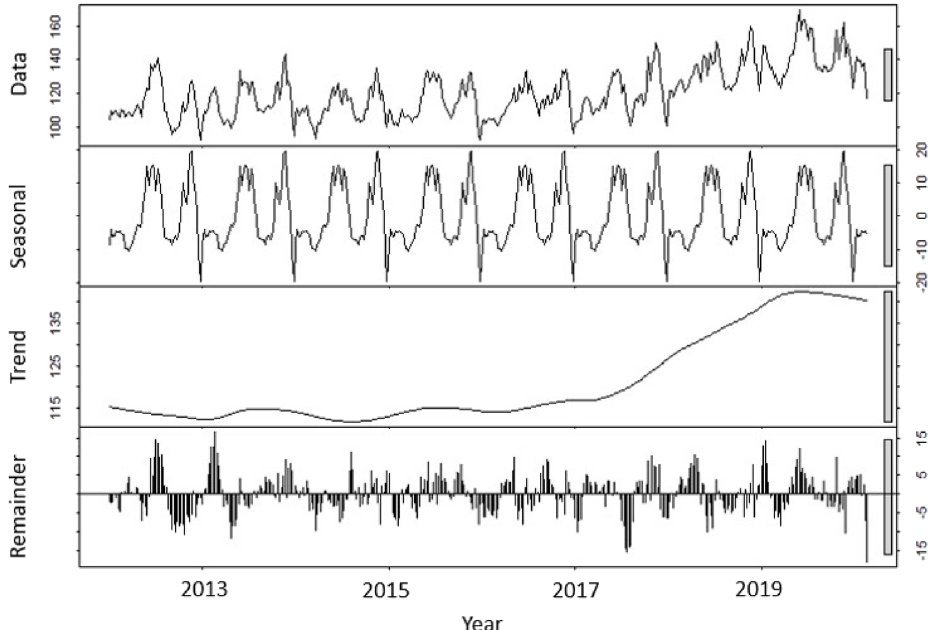
Figure 14. Raw data, seasonal component, trend, and the remainder when the raw data of living organ donors is adjusted by removing the seasonal component.